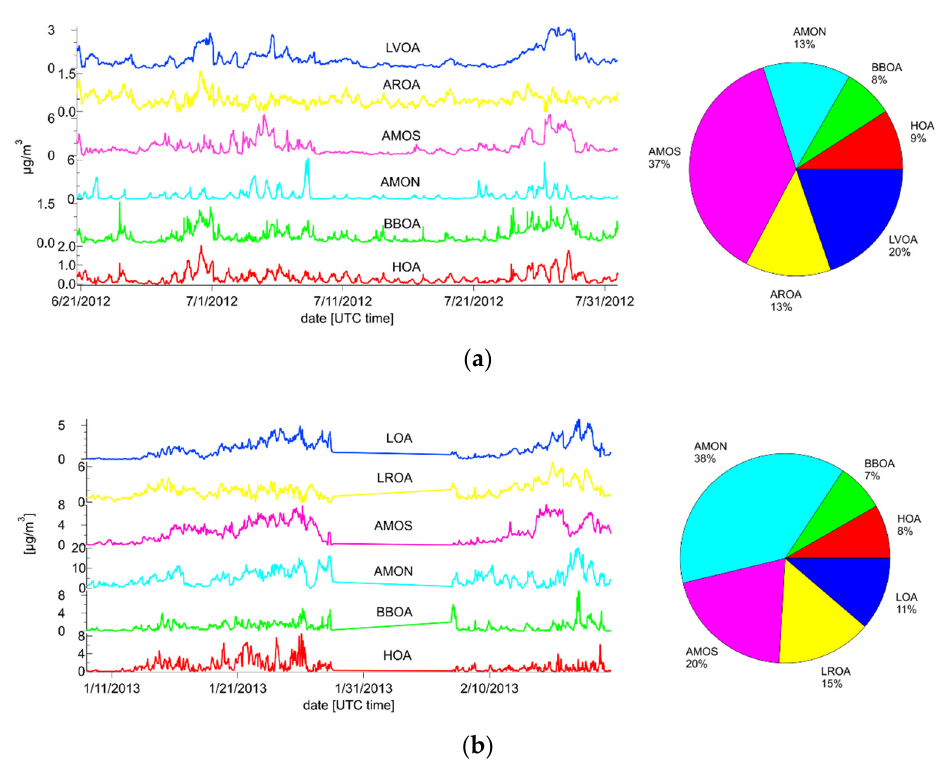
Figure 6. Time series of ( a ) summer concentrations and ( b ) winter concentrations of all factors and their total mass.